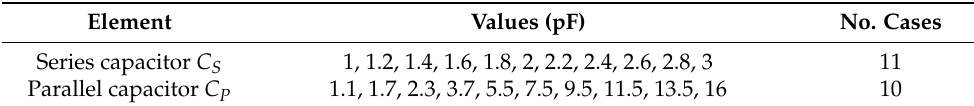
Table 2. Capacitor values in matching circuit for validation.